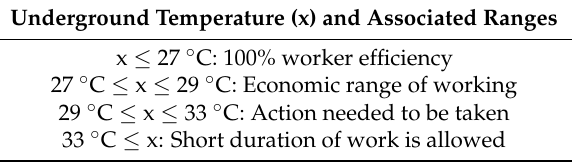
Table 2. Underground wet ‐ bulb temperature ranges [13].